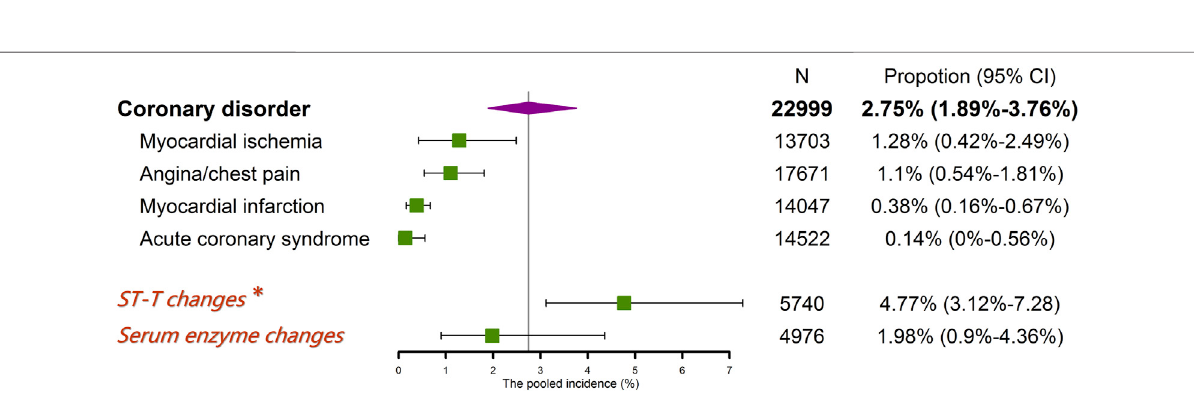
Frontiers in Pharmacology |